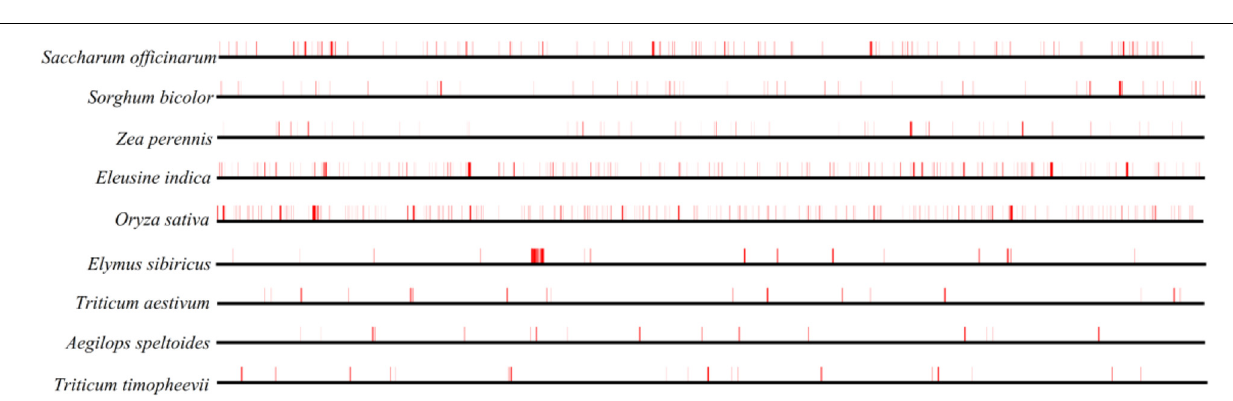
FIGURE 3 | TE prediction of nine Gramineae mitogenomes. The horizontal lines in bold black represent nine mitogenomes, and the vertical red lines indicate the location of the predicted